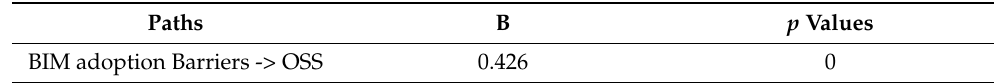
Table 5. Path model